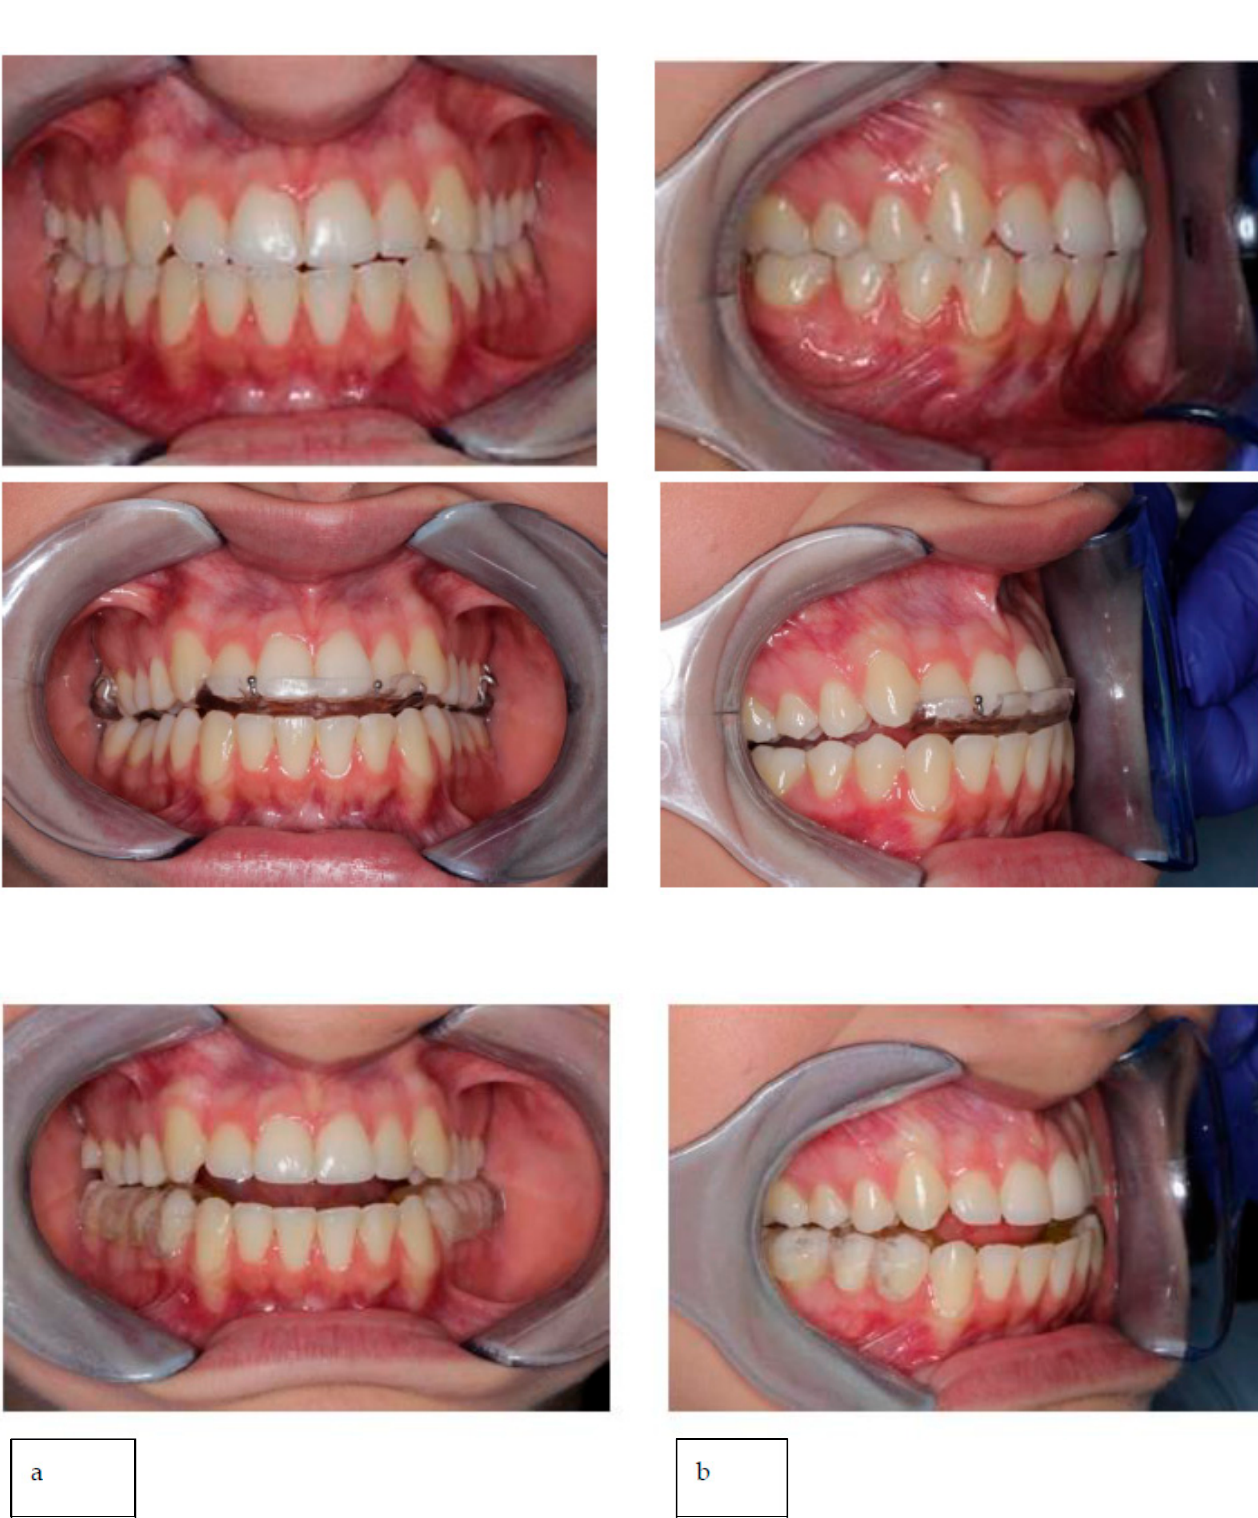
Figure 23. ( a ) Habitual occlusion; ( b ) upper device to be used during the night; and ( c ) lower device to be used during the day. to be used during the